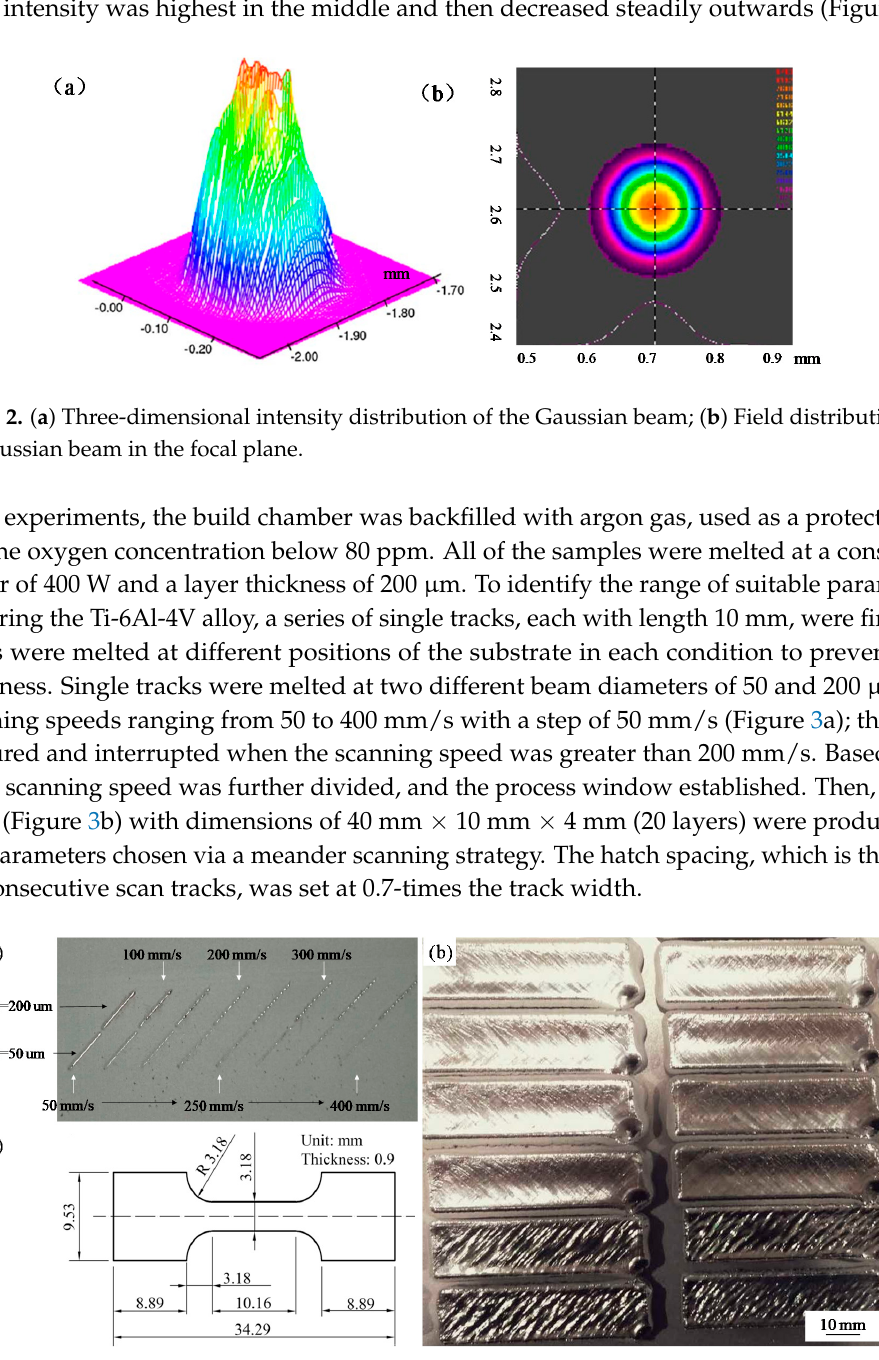
Table 1. The chemical composition of Ti-6Al-4V powder .